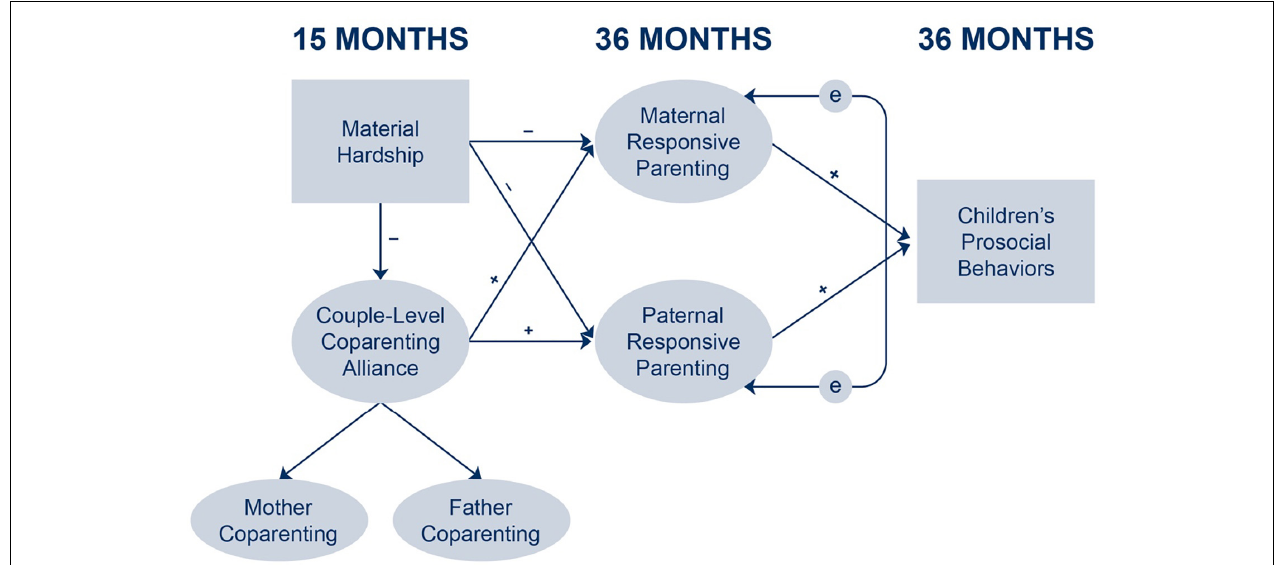
FIGURE 1 | Conceptual model for the current